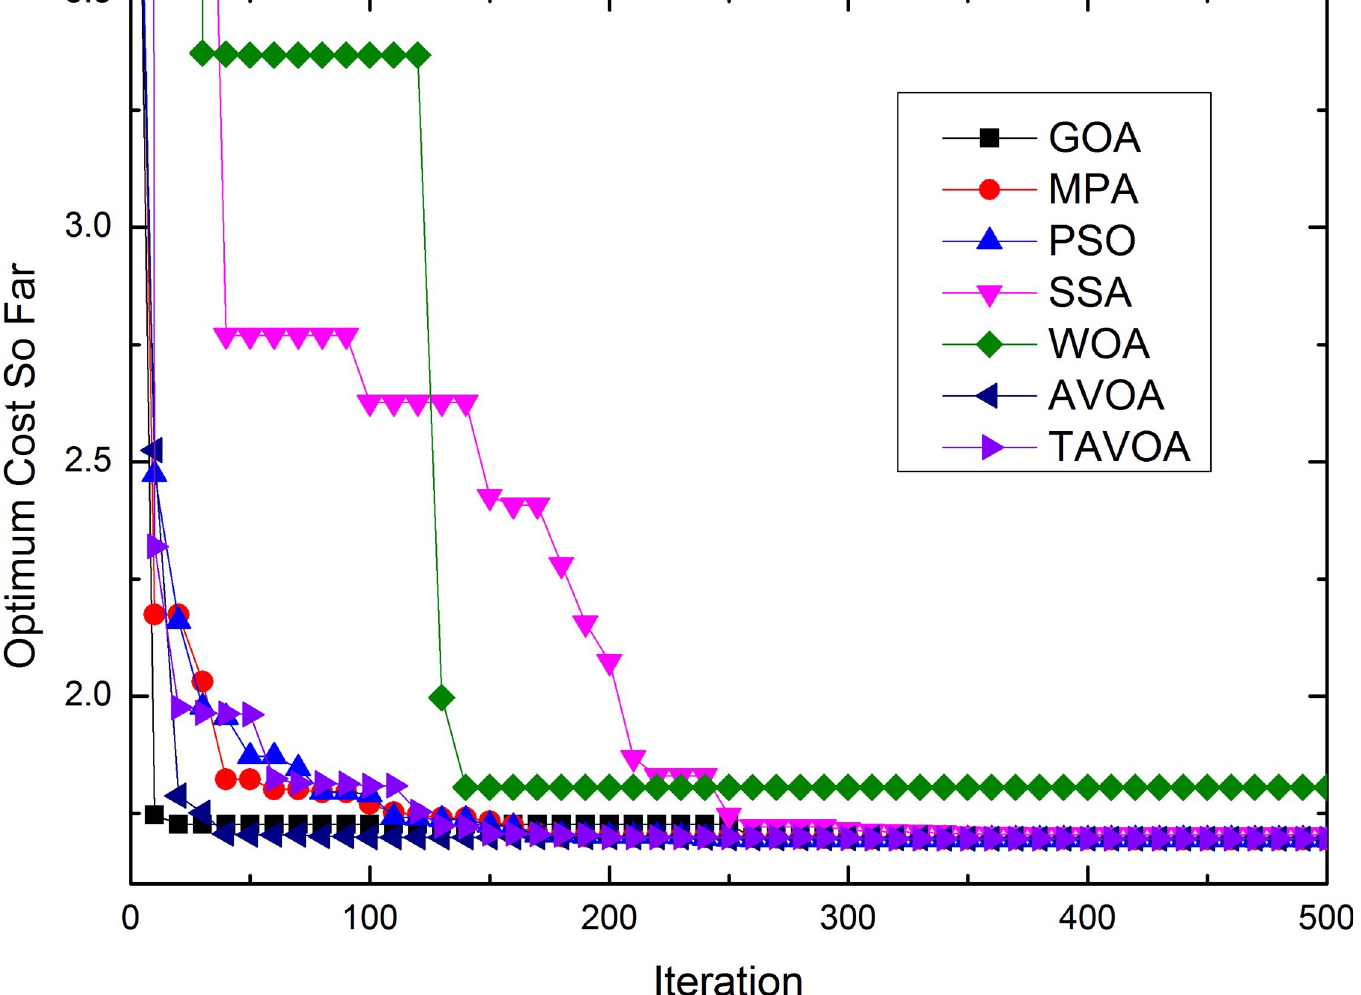
Fig 15. Convergence process in the welded beam design